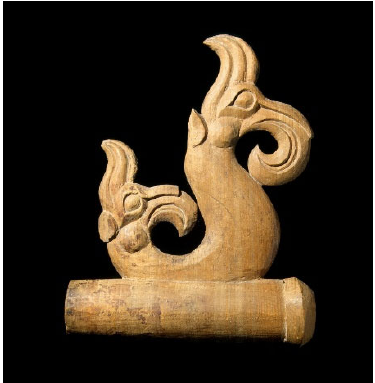
Figure 15. Bridle ornament in the form of two griffins’ heads (SHM inv. no. 2179 ‐ 28); cedar wood; Kurgan 1,